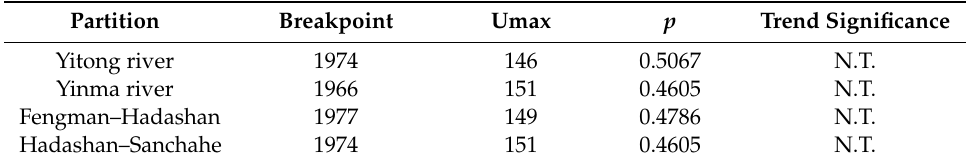
Figure 10. Results of the Pettitt mutation point test for partitions in the SSRB. Table 2. Trend test results of the Pettitt breakpoint test in